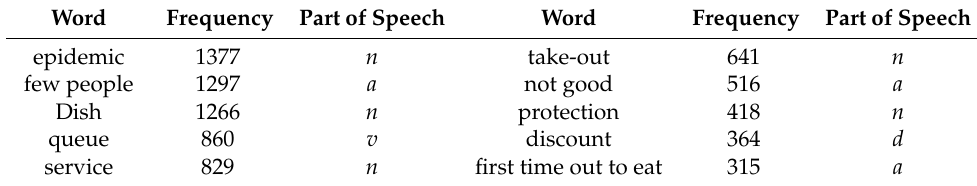
Table 7. Word frequency statistics and part of speech tagging of post COVID-19